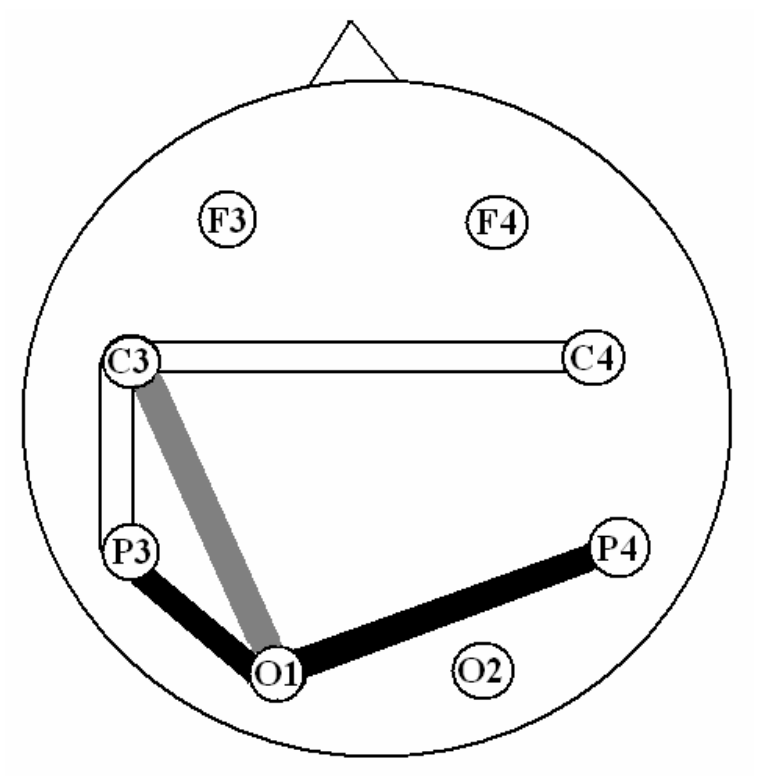
Figure 6. Pairs of EEG electrodes where their coherences in the alpha band demonstrated significant correlations with reaction times (RT). Lines in black present the condition in the ‘early visual phase’; the line in grey presents the condition in the ‘pre execution phase’; lines in white are in the condition of ‘execution phase’. As there is no significant correlations found in the ‘post execution phase’, there is no line for that phase. In this present study, only the inter hemispheric pairs (O1 O2, P3 P4, C3 C4 and F3 F4) were discussed. The results demonstrated only the coherence strength of C3 C4 in the execution phase was negatively correlated to